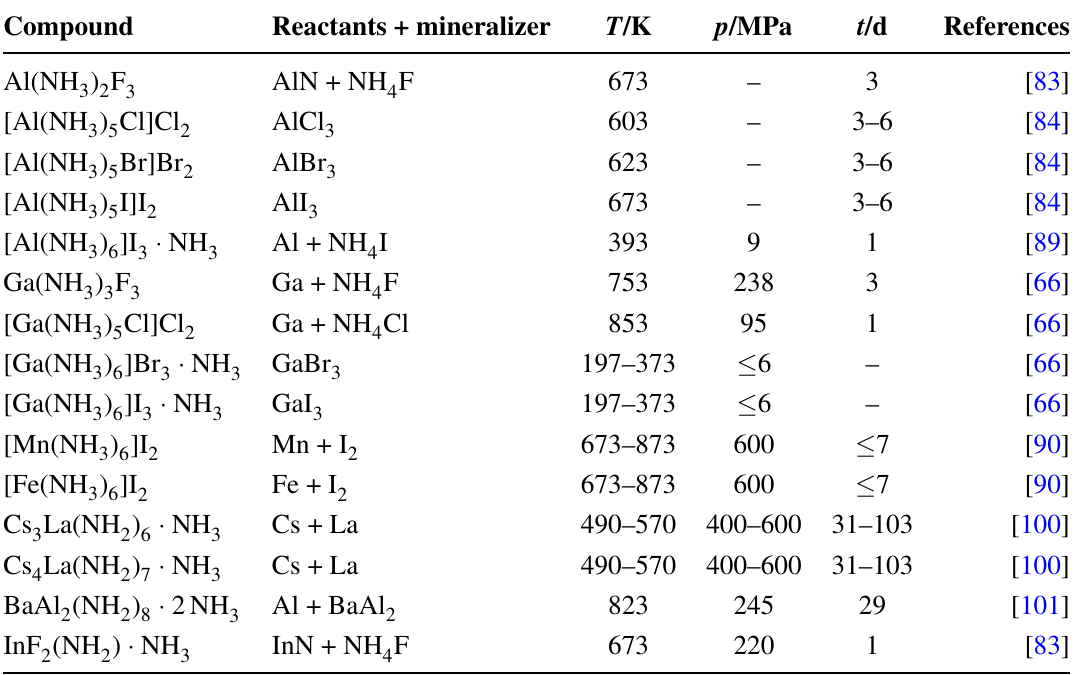
Table 3. Conditions for the ammonothermal crystal growth of metal halide ammoniates and of ammoniates of metal